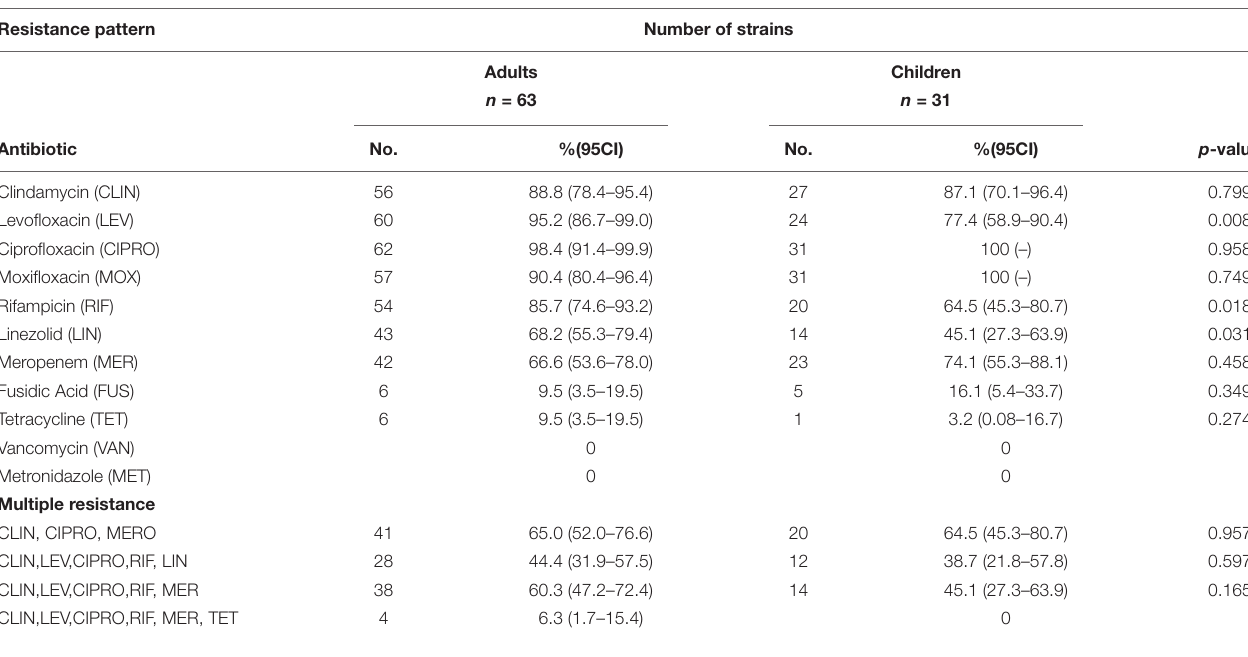
FIGURE 1 | Results of analysis of the whole genome sequences of 94 Clostridiodes difficile isolates from 63 adults and 31 children. (A) Distribution of toxins profile of the isolates. (B) Vamphyre phylogenetic circular tree based on MLST analysis to illustrate the genetic relationships between 20 STs that involve four clades of C. difficile. Each color corresponds to clades (Clade 1 blue, Clade 2 red, Clade 4 dark blue, Clade 5 green). (C) Number of C. difficile strains per MLST clade. (D) Number of STs identified by MLST in the studied isolates. TABLE 1 | Distribution of resistance pattern among Mexican C. difficile